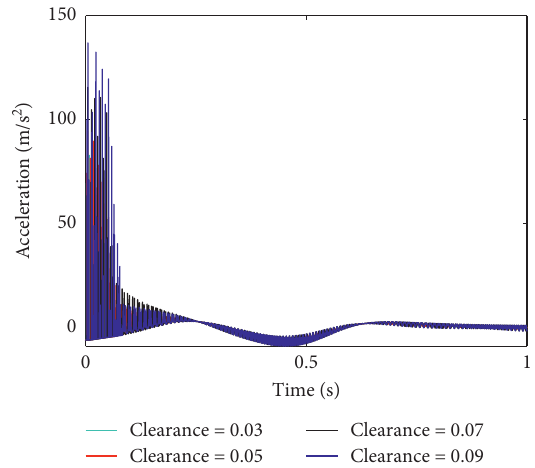
Figure 16: Acceleration of the slider with different clearance values.